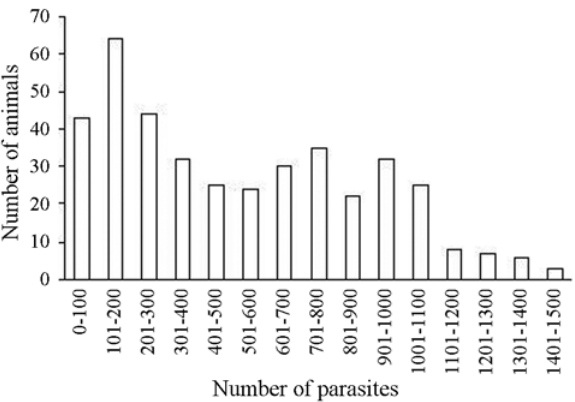
Figure2 -Frequencydistributionofthenumberof S.venezuelensis recov- ered from the small intestines of F2 mice seven days after infection with 2000